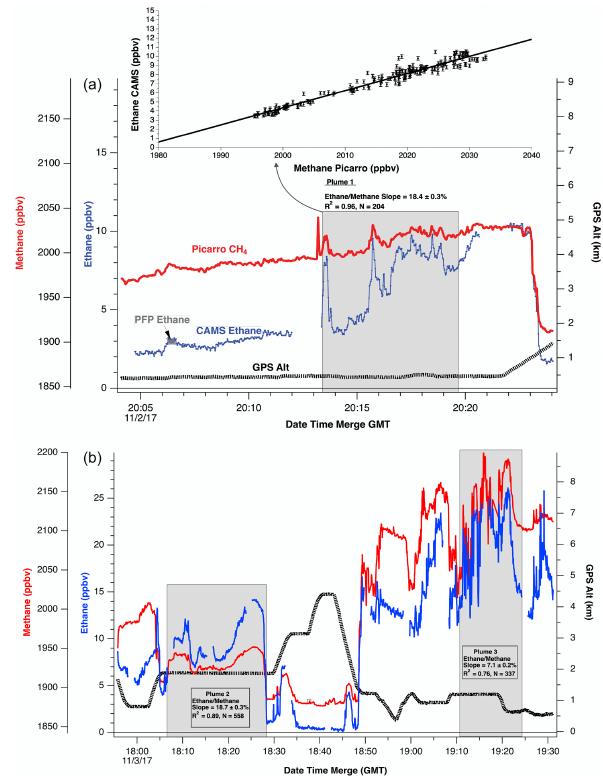
Figure 12. (a) Ethane–methane time series plot for plume 1 high- lighted in Fig. 11. The CAMS ethane (blue trace) compares well with the PFP ethane measurement shown by the solid gray hori- zontal points around 20:06. As shown, the ethane–methane slope is 18.4%. (b) Ethane–methane time series plots for plumes 2 and 3 highlighted in Fig.